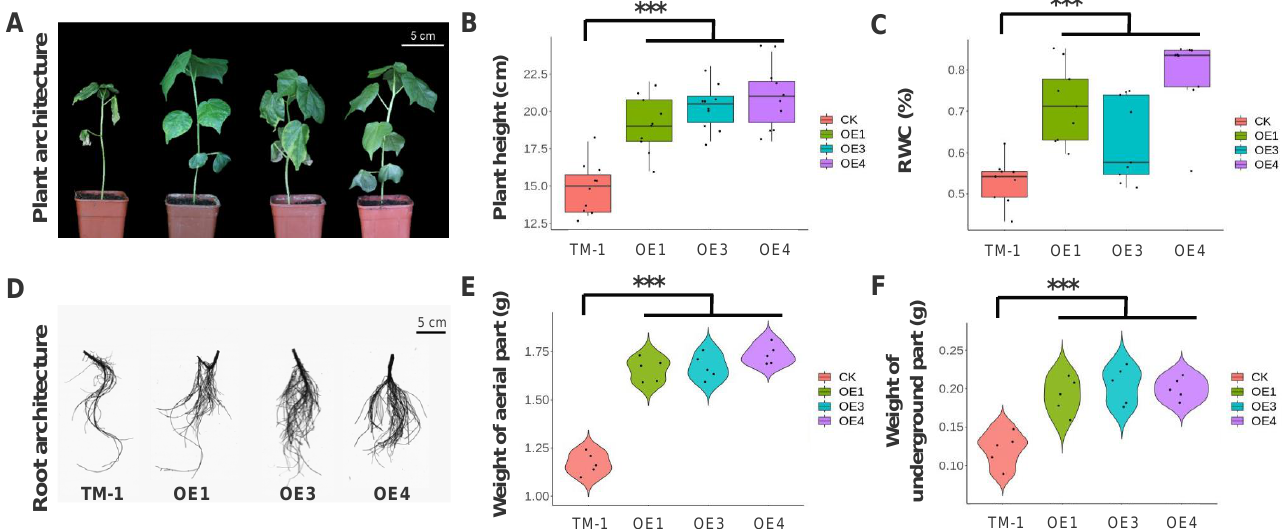
Figure 4. Drought treatment and physiological indicators of overexpression com58276 cotton. ( A ) Plant architecture of TM-1 and OE1, OE3, and OE4 after drought treatment. ( B ) The plant height of TM-1 and OE1, OE3, and OE4. ( C ) The relative water content (RWC) of TM-1 and OE1, OE3, and OE4. ( D ) Root architecture of TM-1 and OE1, OE3, and OE4. ( E,F ) The weight of superficial and underground structures of TM-1 and OE1, OE3, and OE4 plants. (*** p < 0.001, Dunn’s